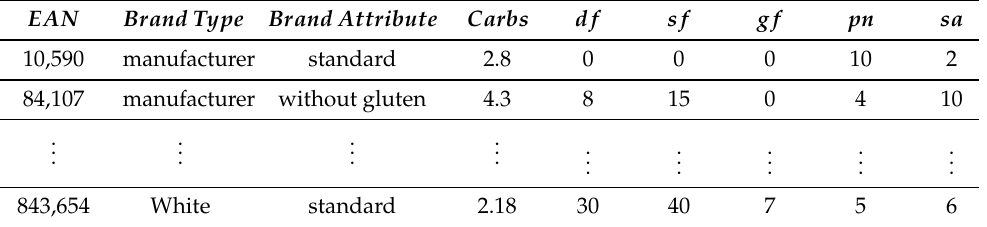
Table 4. Extract of the